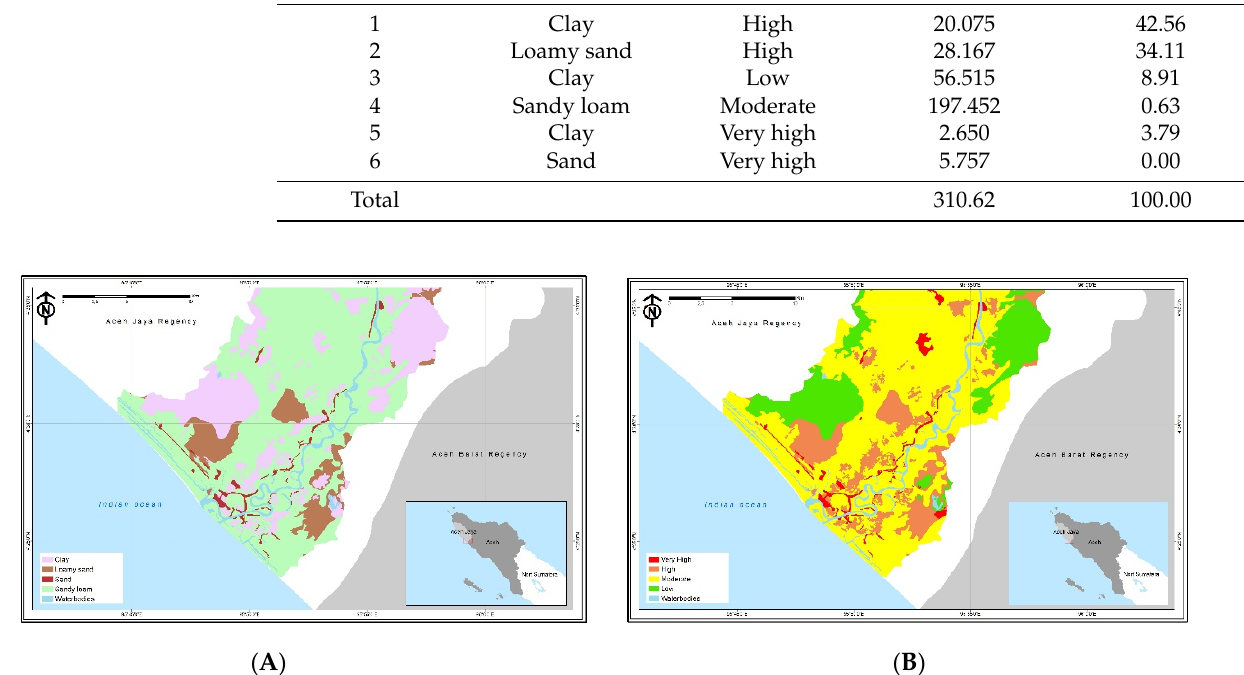
Figure 8. Soil type map ( A ) and soil flood risk map ( B ) of Krueng Teunom